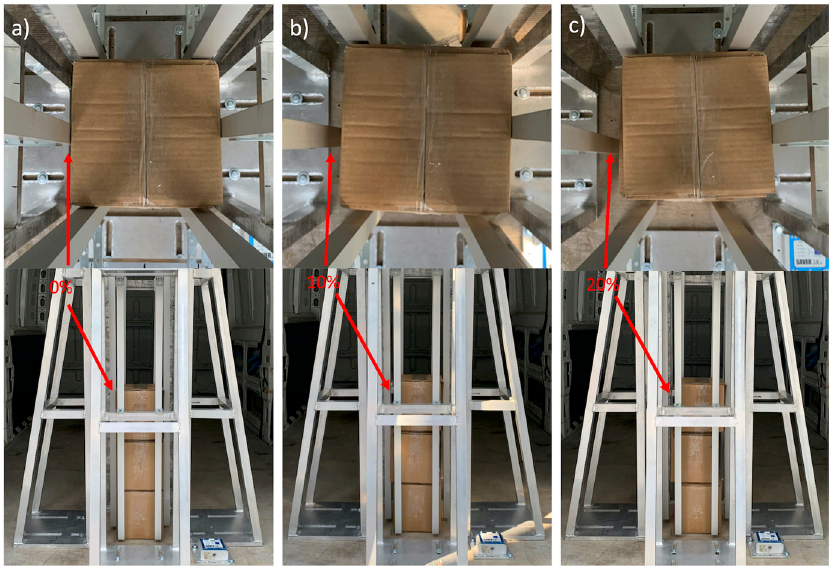
Figure 3. ( a ) Sample stacked unit in a van with fences of free movement (FM) 0%, ( b ) FM 10%, and ( c ) FM